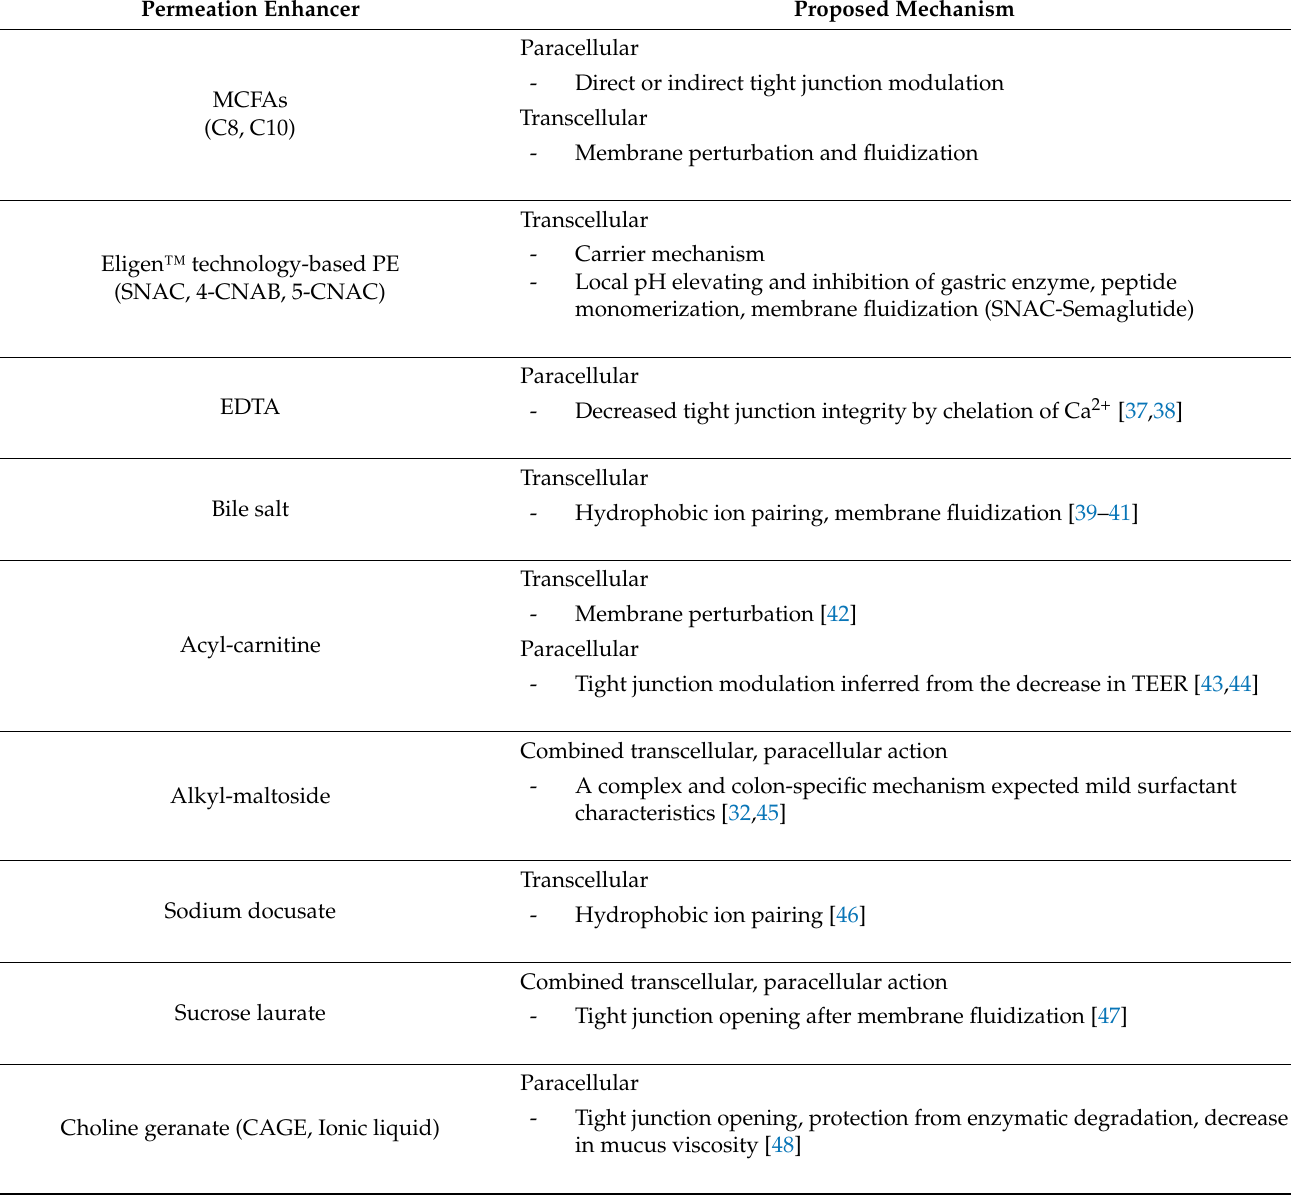
Table 1. Summary of chemical permeation